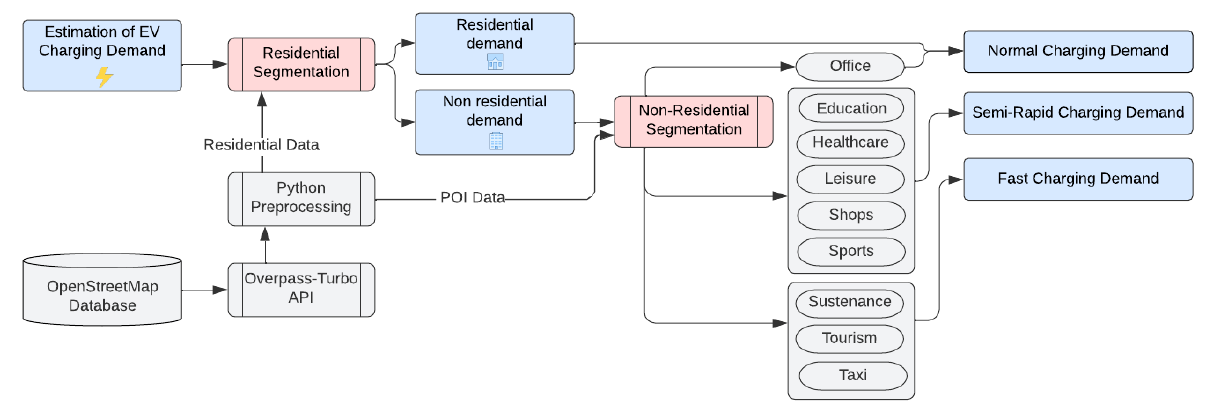
Figure 4. This diagram shows the complete segmentation process. The two segmentation steps are highlighted in red. First, the residential segmentation called Highways Analysis is presented in Section 3.2.2. Second, the non-residential segmentation called the POI-based segmentation is presented in Section 3.2.3. The charging demand at various stages is represented as blue cells. The data used in the model is extracted from the OpenStreetMap databases through the Overpass- Turbo